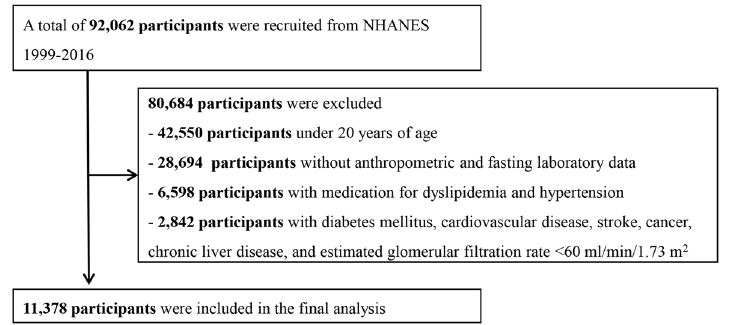
Figure 1. Flowchart showing the final selection process.